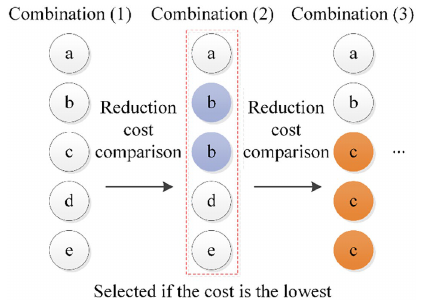
Figure 2. Example of how to select the lowest-cost activities